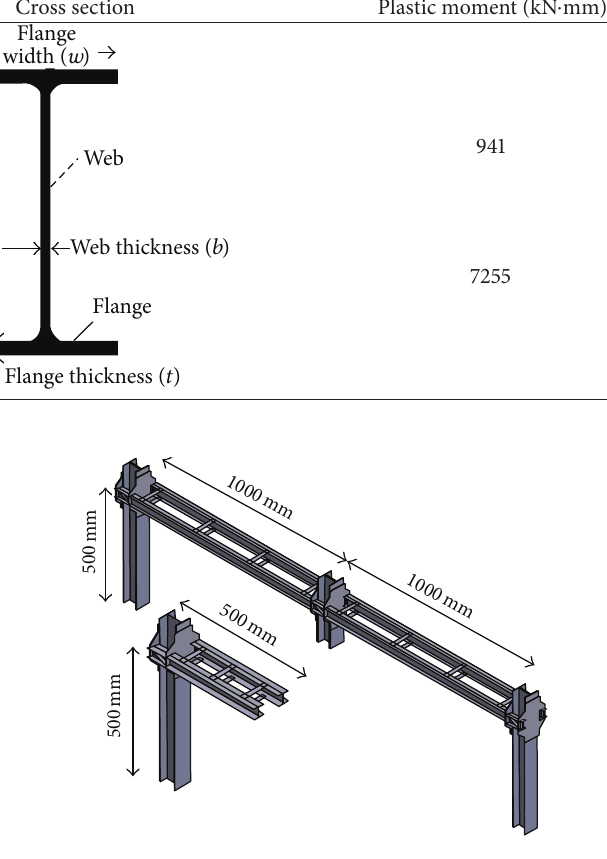
Figure 9: Case studies for seismic and progressive collapse assess-